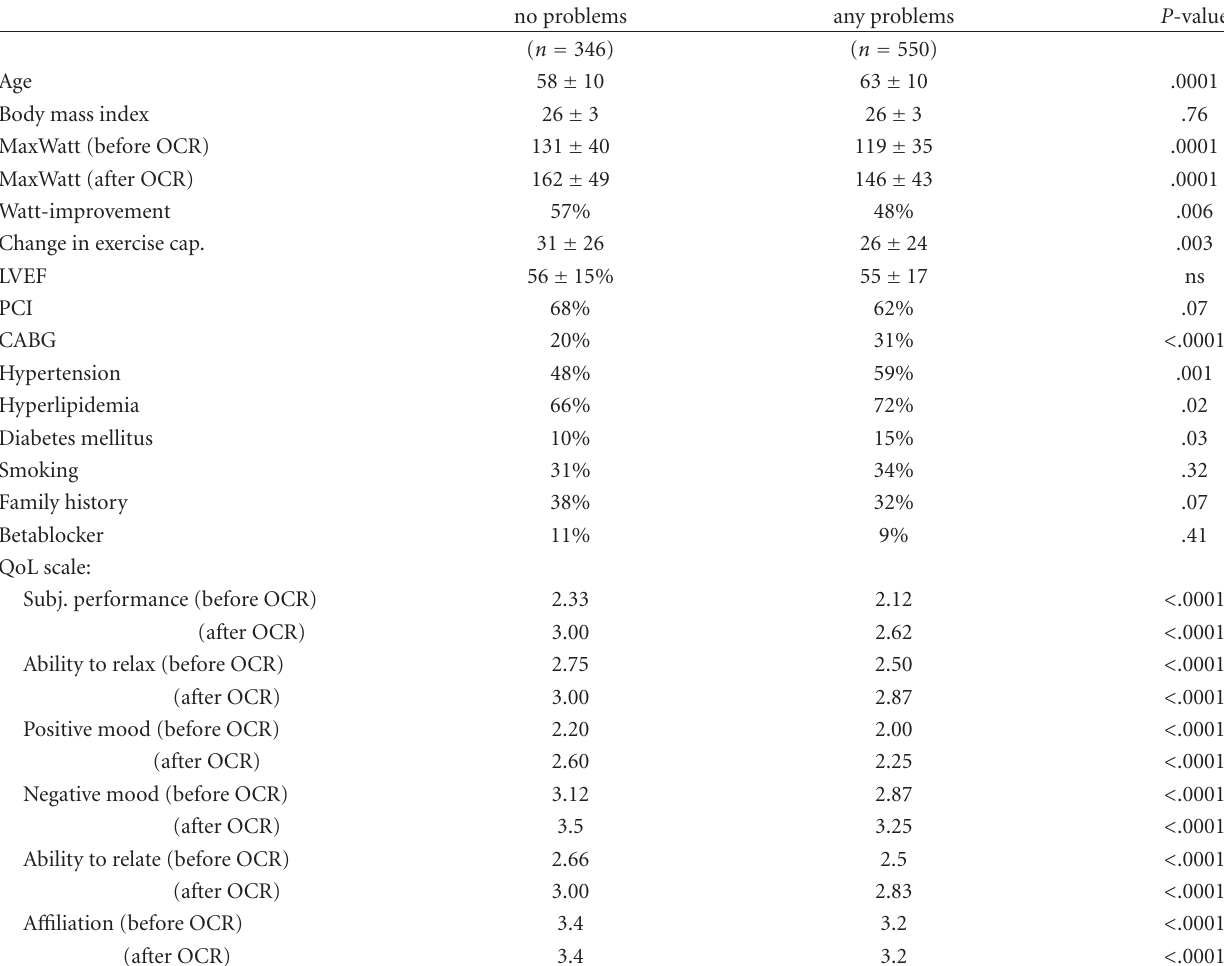
Table 4: Univariate analysis of variables related to any problems with sexual activity after